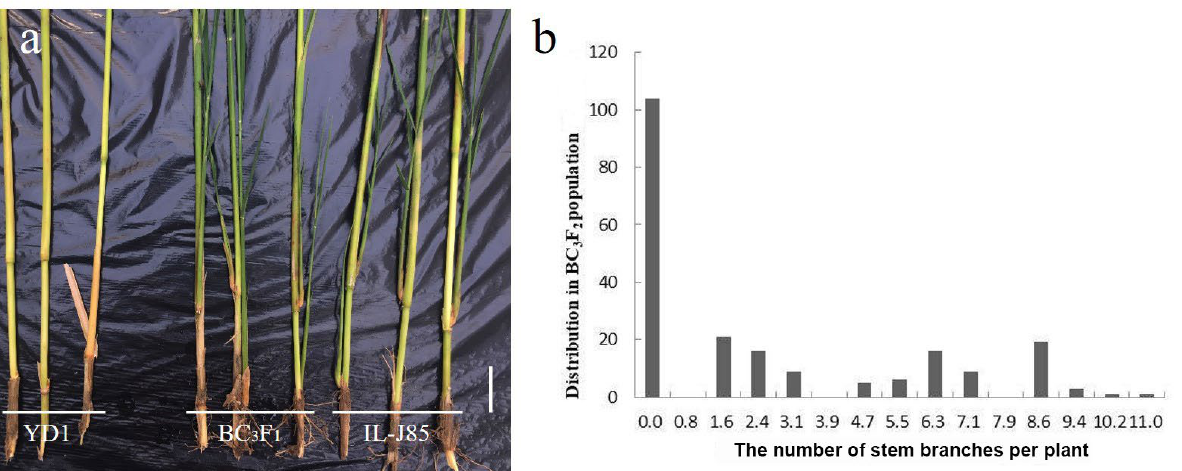
Figure 2. The phenotype of BC 3 F 1 in the mature period and the distribution in BC 3 F 2 population. ( a ) YD1, BC 3 F 1 , and IL-J85 15 days later after harvest (bar = 10 cm). ( b ) The distribution in BC3F2 population based on the number of stem branches per plant (N = 210).